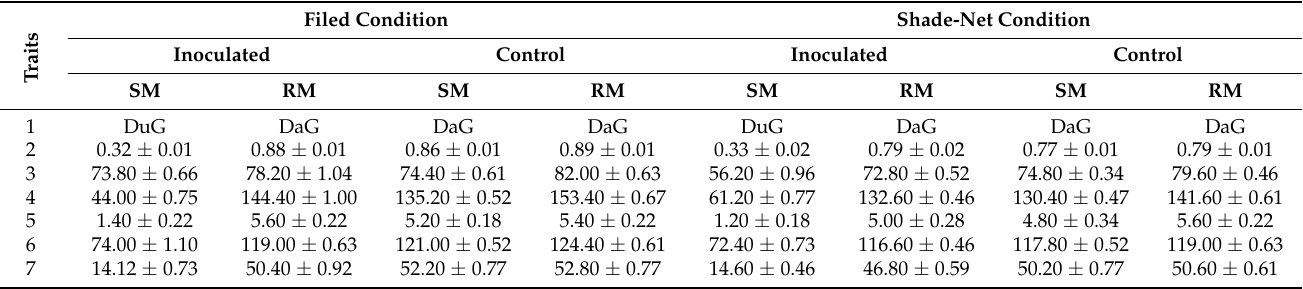
SM—Susceptible mutant. RM—Resistant mutant. DuG—Dull green. DaG—Dark green. 1—Leaf colour. 2—Chlorophyll fluorescence (a/b ratio). 3—No. flowering clusters/plant. 4—No. of pods/plant. 5—No. of seeds/pod. 6—Days to maturity. 7—Single plant yield